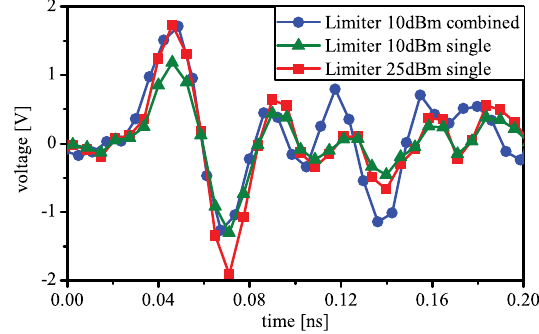
FIG. 7. Comparison of the measured beam-induced pickup signal. A single and a combined pickup signal is compared with two types of